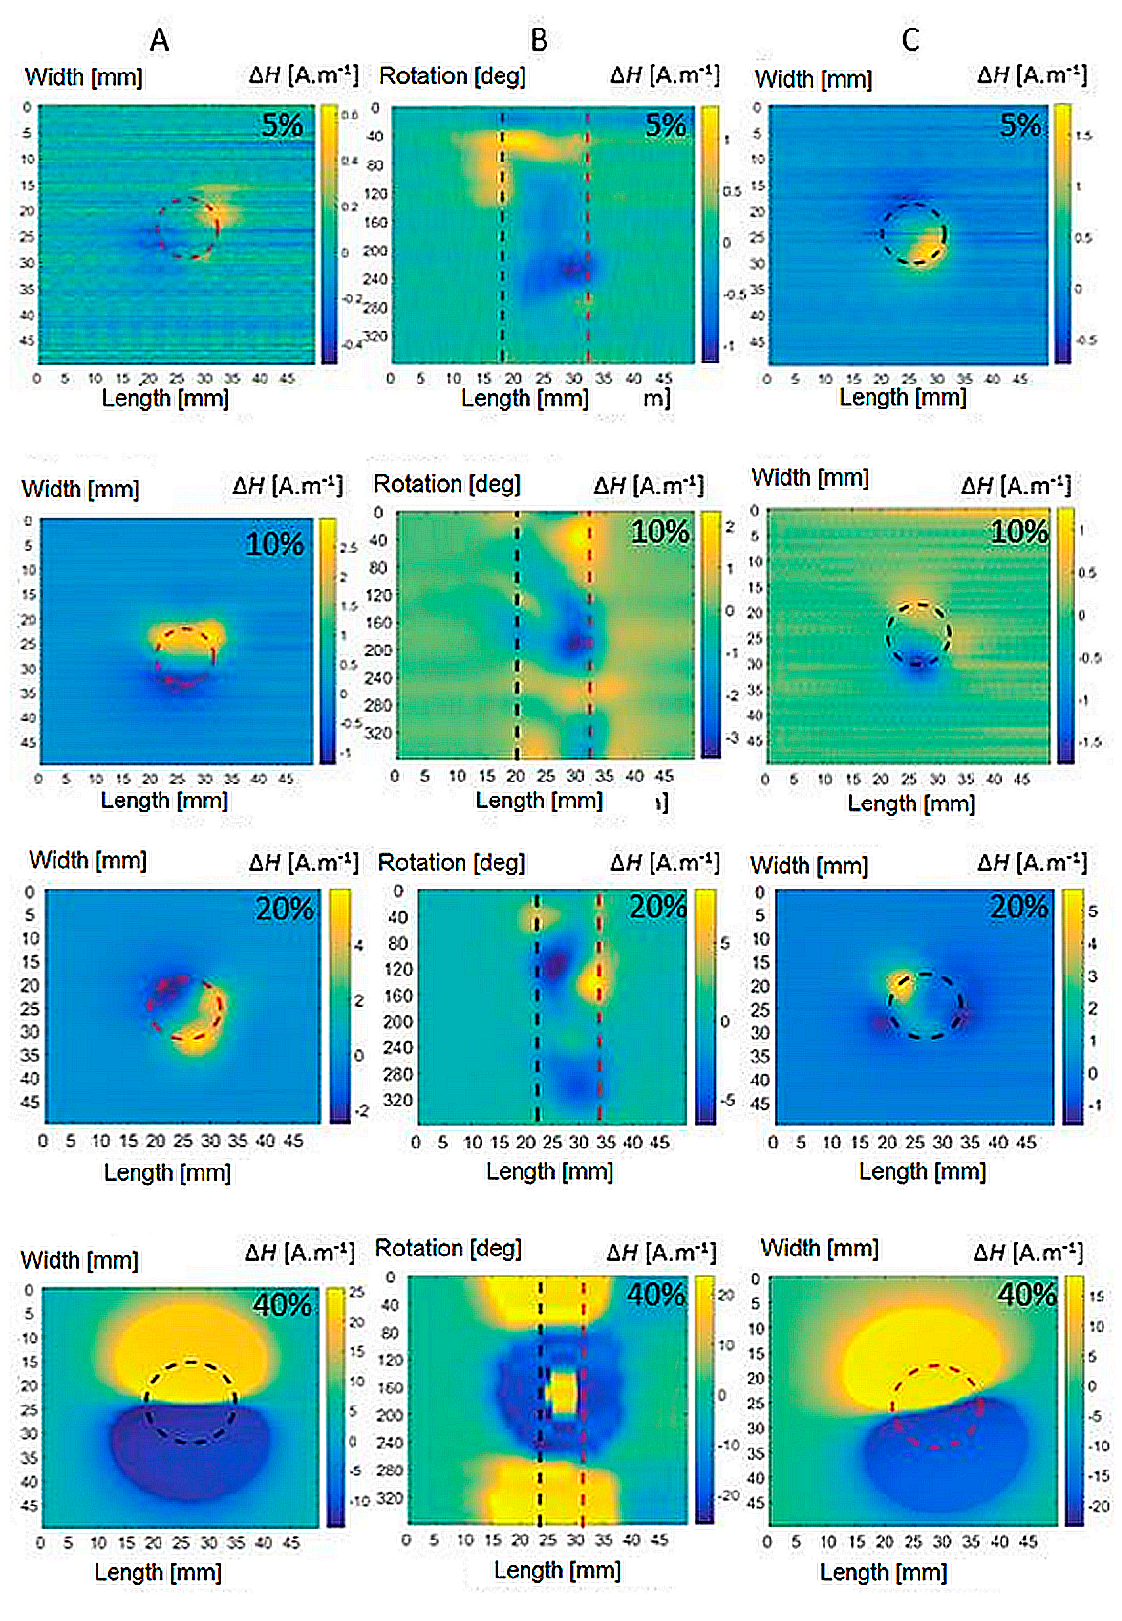
Figure 13. Magnetic field distribution of bases ( A , C ) and shell ( B ) of AISI 304 specimens of all plastic deformations.